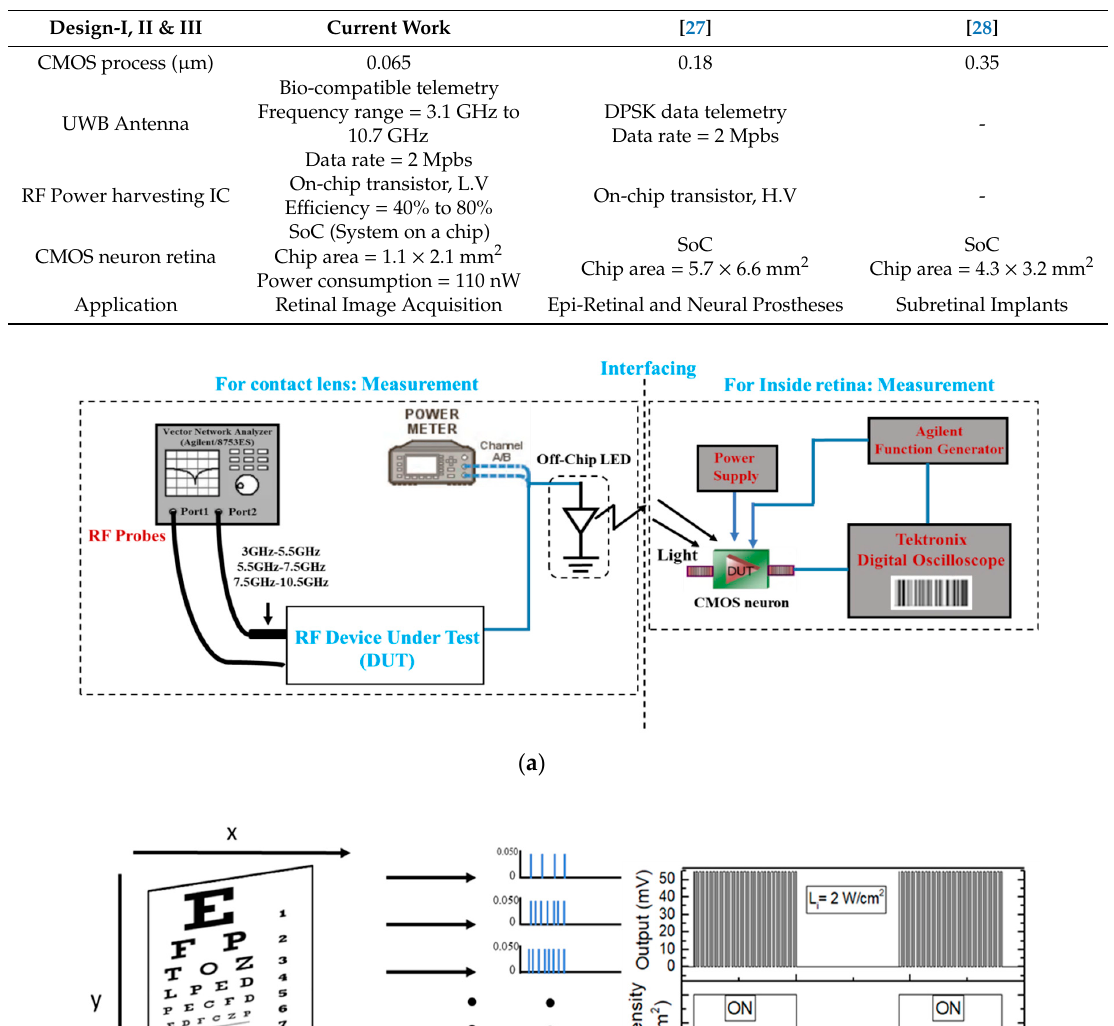
Table 2. Comparison performance of current work with reported ones.